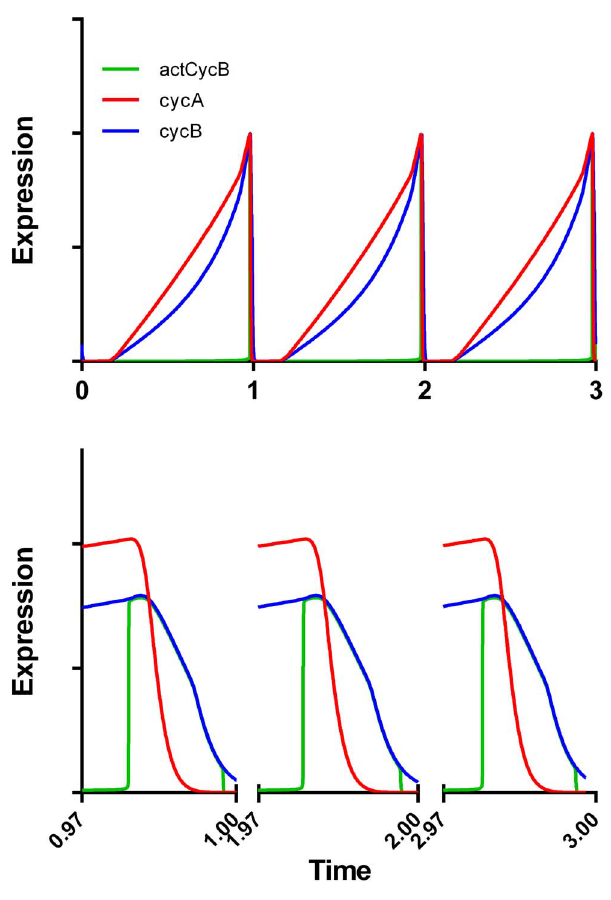
Figure 6. Simulated expression over three successive cell cycles. Model outputs were normalized to zero and one prior to plotting. cycB=total B cyclin; cycA=total A cyclin, and actCycB=active B cyclin (CycB:Cdk1 in Figure